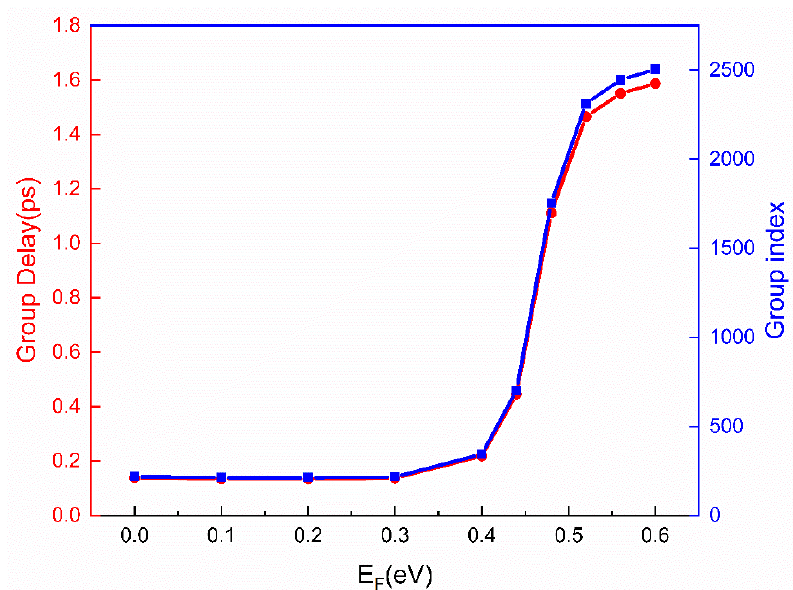
Figure 8. The slow light effect of the proposed metamaterial. Group delay (red) and group index (blue) at different Fermi levels.